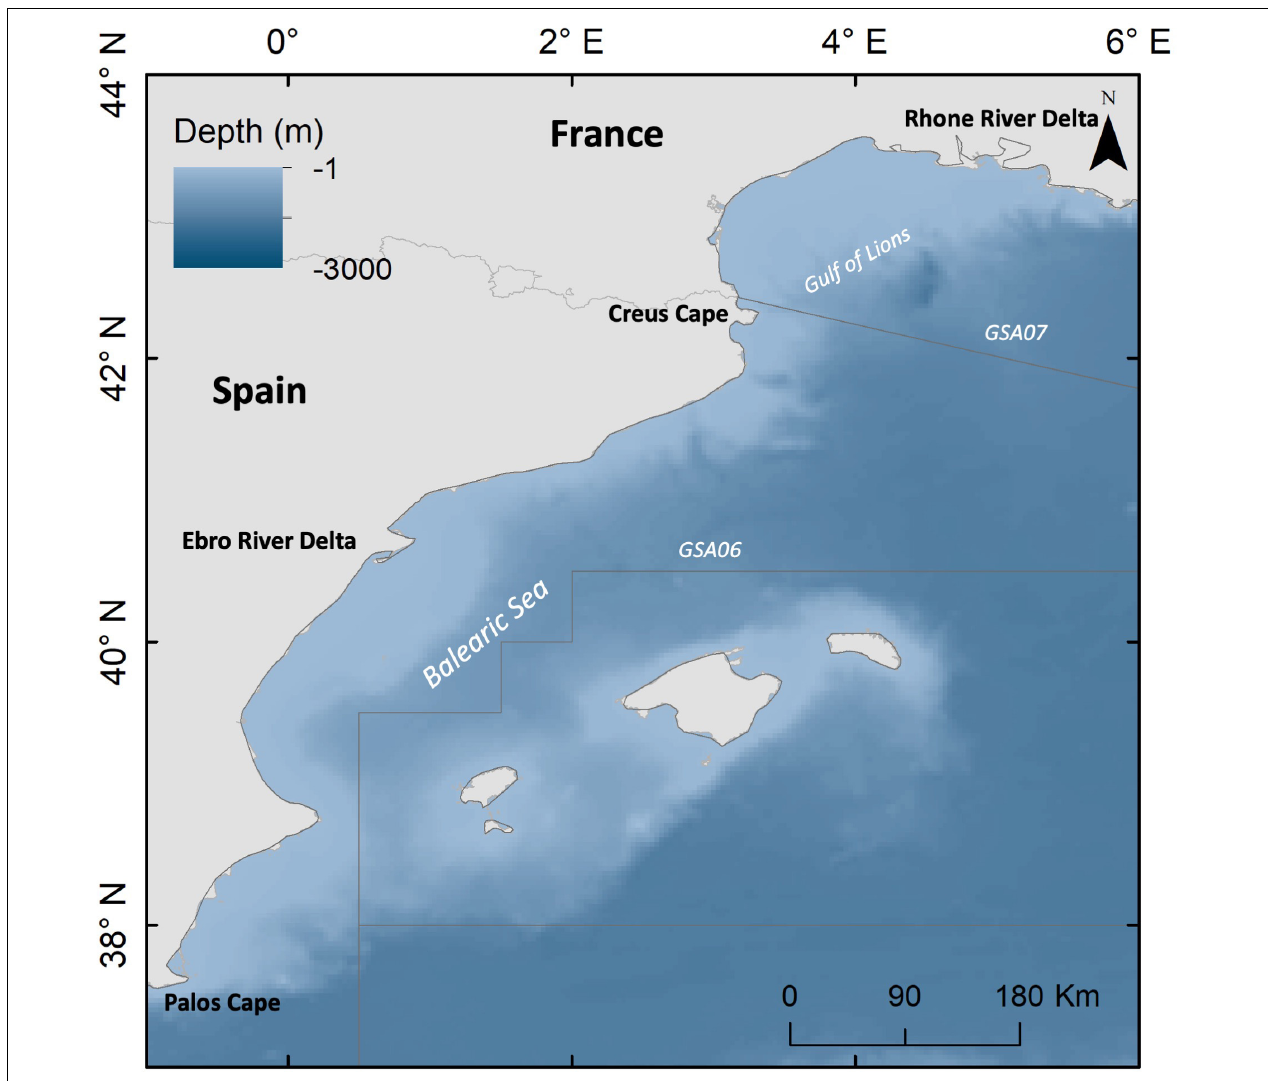
FIGURE 1 | Map of the study